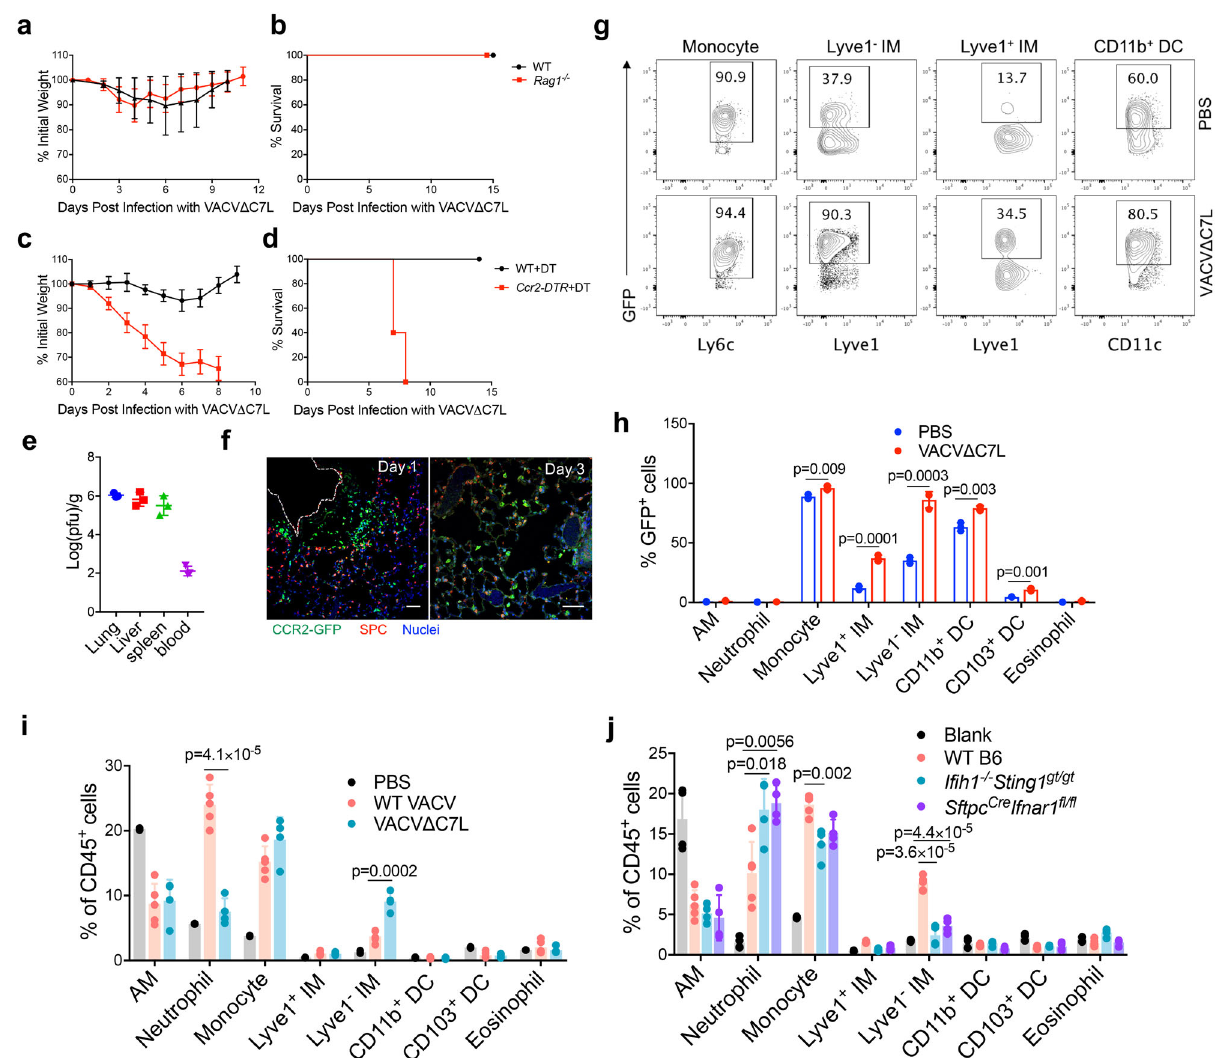
Fig. 5 CCR2 + in fl ammatory monocytes and its derived Lyve1 - interstitial macrophages function in restricting VACV Δ C7L infection. a , b shown are the percentages of initial weight a or Kaplan – Meier survival curve b over days post intranasal infection with VACV Δ C7L at 2 × 10 7 pfu in Rag1 − / − and age- matched WT C57BL/6J mice. ( n = 5 in each group). c , d shown are the percentages of initial weight c or Kaplan-Meier survival curve d over days post intranasal infection with VACV Δ C7L at 2 × 10 7 pfu in Ccr2-DTR and age-matched WT C57BL/6J mice treated with DT ( n = 5 in each group). e Titers of VACV Δ C7L in the lungs, livers, spleens, and blood of Ccr2-DTR mice mice treated with DT at day 4 post intranasal infection with VACV Δ C7L at a dose of 2 × 10 7 pfu. f Representative confocal images showing location of CCR2 + cells in adult lungs from Ccr2-GFP mice infected with VACV Δ C7L at 2 ×10 7 pfu collected at day 1 or day 3 post infection. Scale bar, 50 μ m. g , h Representative fl ow cytometry dot plots g and bar graph h showing an increase of GFP + Lyve1 - IMs, GFP + Lyve1 + IMs, GFP + Ly6C + monocytes and GFP + MHCII + CD11C + DCs in the lungs of Ccr2-GFP mice at day 3 post infection with VACV Δ C7L at 2 × 10 7 pfu compared with PBS-mock infected mice ( n = 3 in each group). i Flow cytometry analysis showing changes of myeloid cells in the lungs of C57BL/6J mice at day 3 post infection with WT VACV, VACV Δ C7L at 2 × 10 7 pfu or PBS-mock infected mice ( n = 2 – 5 in each group). j Flow cytometry analysis showing changes of myeloid cells in the lungs of WT C57BL/6J, I fi h1 − / − Sting1 gt/gt or Sftpc cre Ifnar1 fl / fl mice at day 3 post infection with VACV Δ C7L at 2 × 10 7 pfu. PBS was used as a mock infection blank control in WT mice ( n = 4 – 5 in each group). Two-tailed unpaired Student ’ s t test was used for comparisons of two groups in the studies. Data are representative of two ( a - b , f – h ) or three ( c – e , i – j ) independent experiments and presented as mean ± SD. Source data are provided as a Source Data fi day 5 post-infection with WT VACV (Supplementary Fig. 6g). In